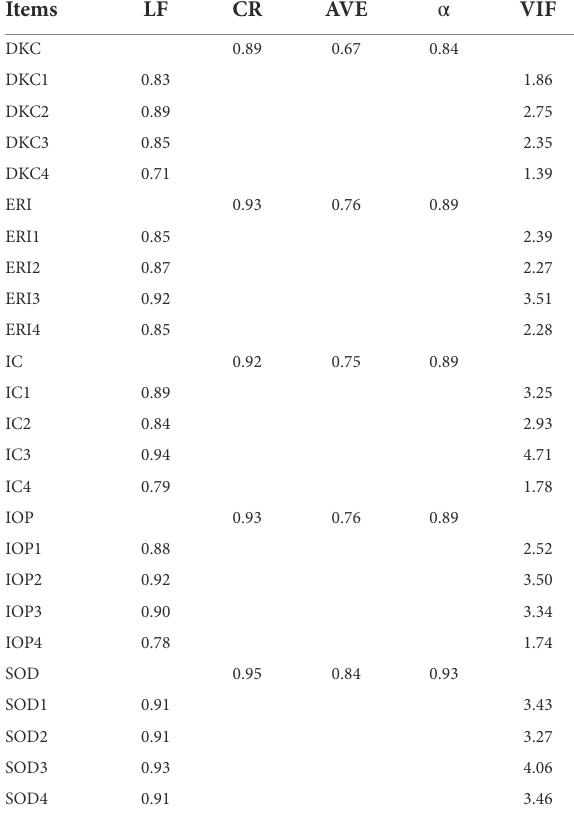
TABLE 2 The qualities of measurements of selected